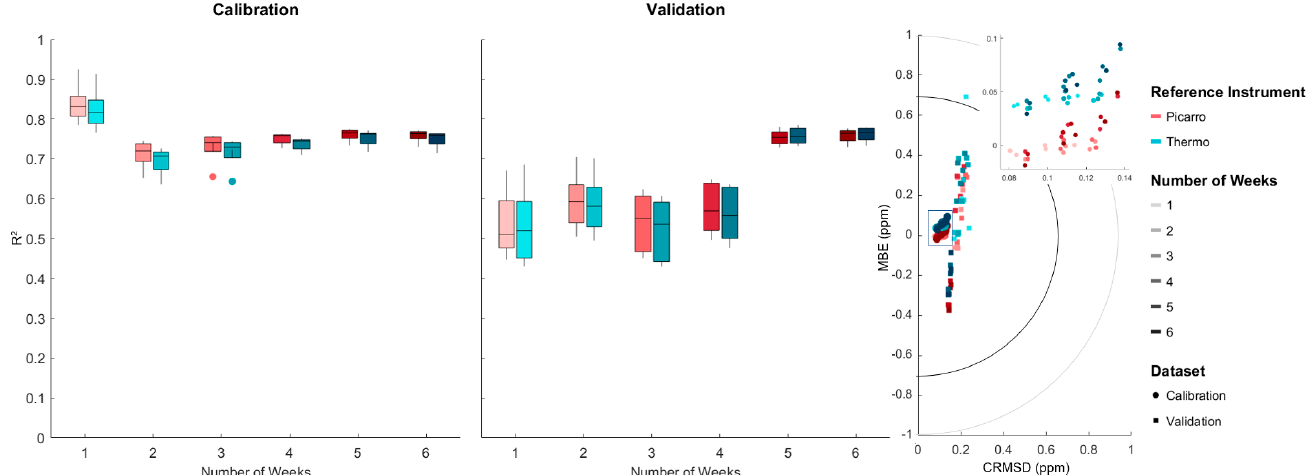
Figure 7. R 2 ( left ) and MBE vs. CRMSD target plot ( right ) for individually calibrated pods as compared with two different reference instruments, using different durations of co-location. In each boxplot column, the leftmost box-and-whisker represents the Picarro data, while the rightmost is the Thermo data.